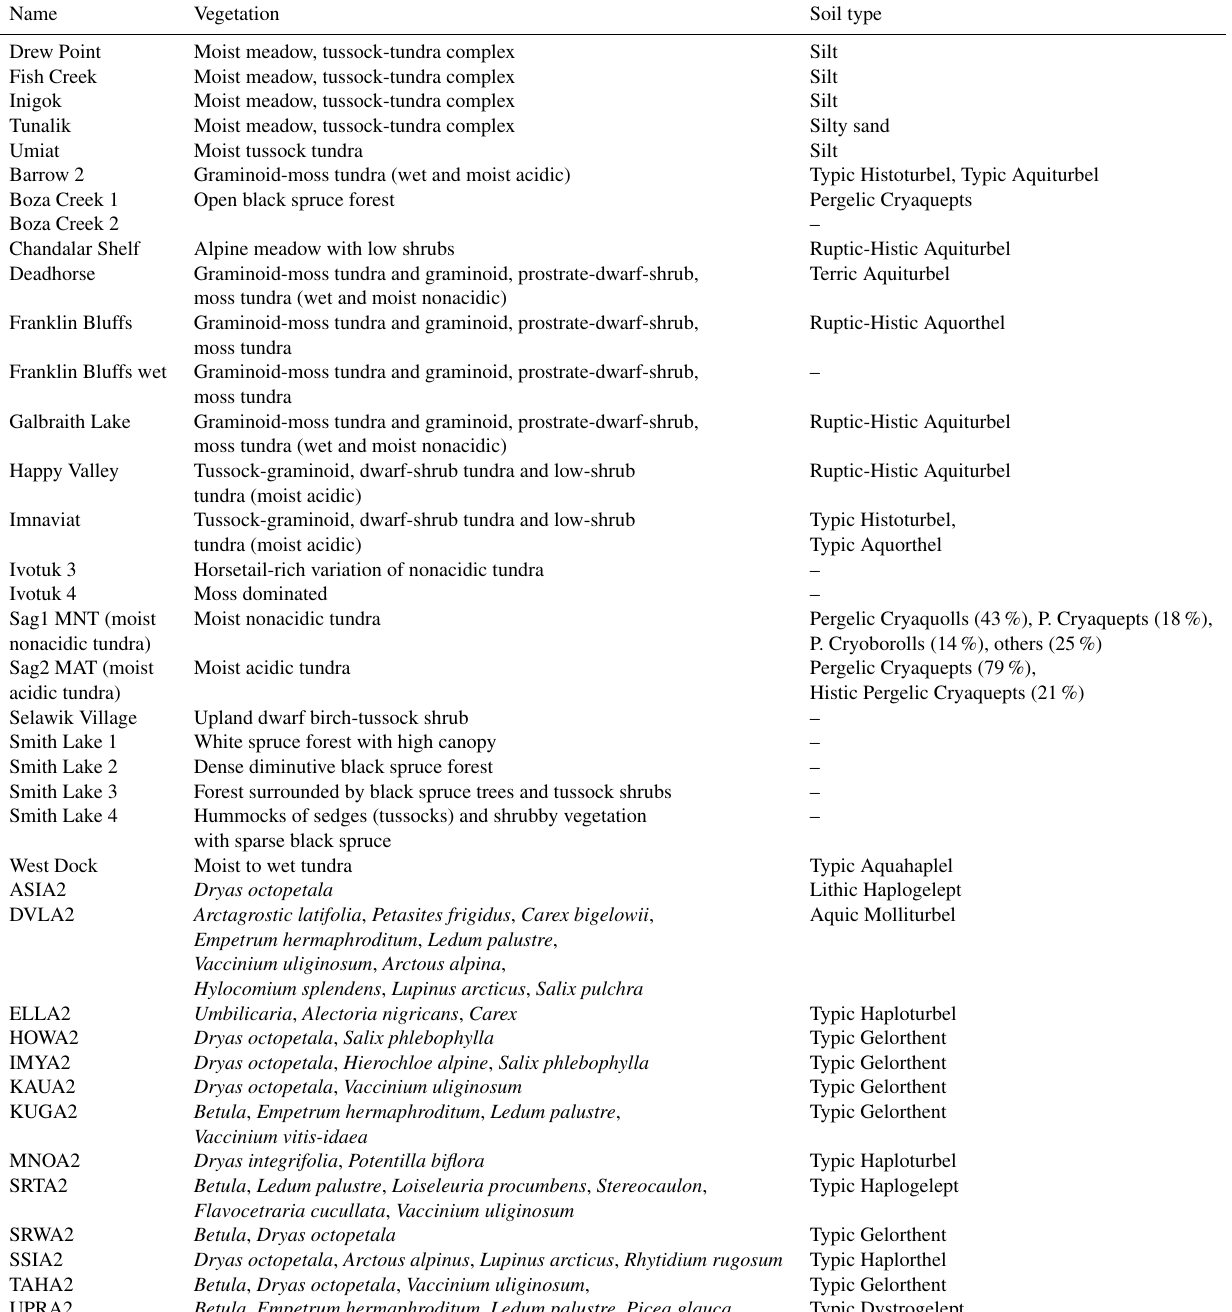
Table 2. Brief description of vegetation and soil type of monitoring stations in